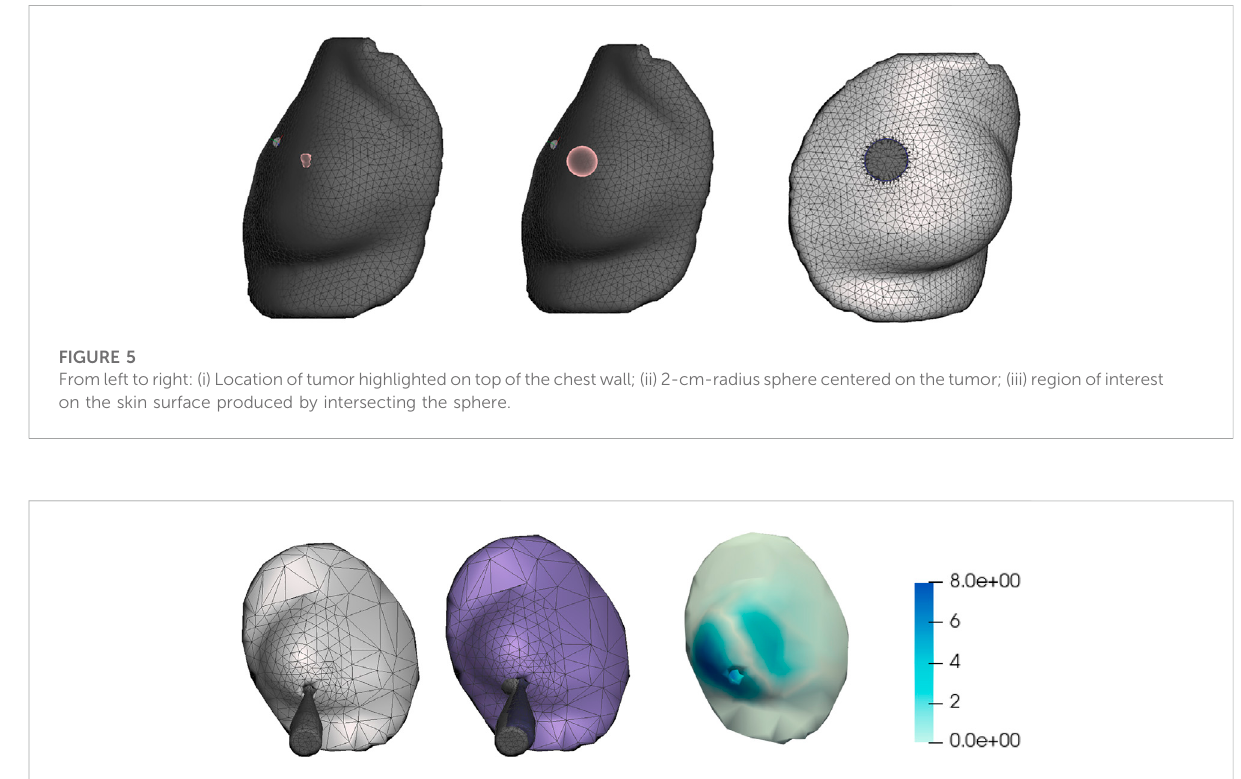
FIGURE 6 Quantitative evaluation of real-time deformation for intraoperative tracking. From left to right: (i) Initial simulation mesh (in grey), showing the IORTapplicator;(ii)Simulationmesh(inpurple)aftermovingtheapplicatoratotaldistanceof8.7 mm,withtheinitialand fi nalapplicatorsoverlaid;(iii) Per-vertex distances between initial and fi nal position (in mm). The simulation is executed at a speed that allows a motion of the applicator of 29